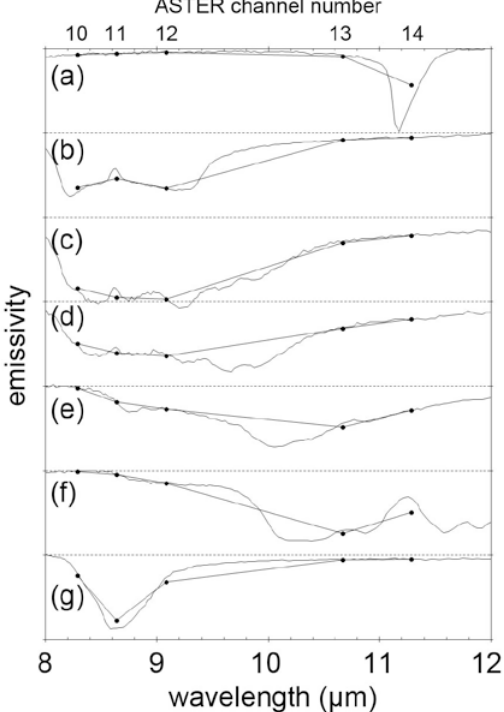
Figure 3. Emissivity spectra for common rock types ( a ) carbonate rock; ( b ) quartzose sedimentary rock; ( c ) felsic rock (granite); ( d ) intermediate rock (diorite); ( e ) mafic rock (gabbro); ( f ) ultramafic rock (dunite); ( g ) gypsum (modified after Ninomiya et al. [17]). Each tick in the Y axis denotes 1.0/0.75 of emissivity except for ( b ) where it denotes 1.0/0.5 of emissivity.